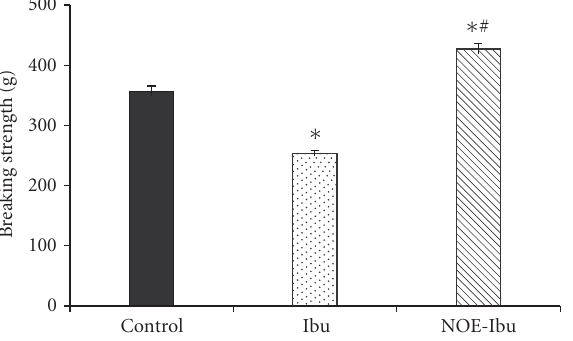
Figure 1: E ff ect of drugs on breaking strength of 10-day-old incision wound. Each bar represents mean ± SEM. Control animals were administered 4% suspension of gum Acacia at dose 5mL/kg, Ibu group received 200 mg/kg of ibuprofen and NOE-Ibu received 300 mg/kg nitrooxyethyl ester of ibuprofen. Mean value of 8 animals gave the breaking strength of the given group.